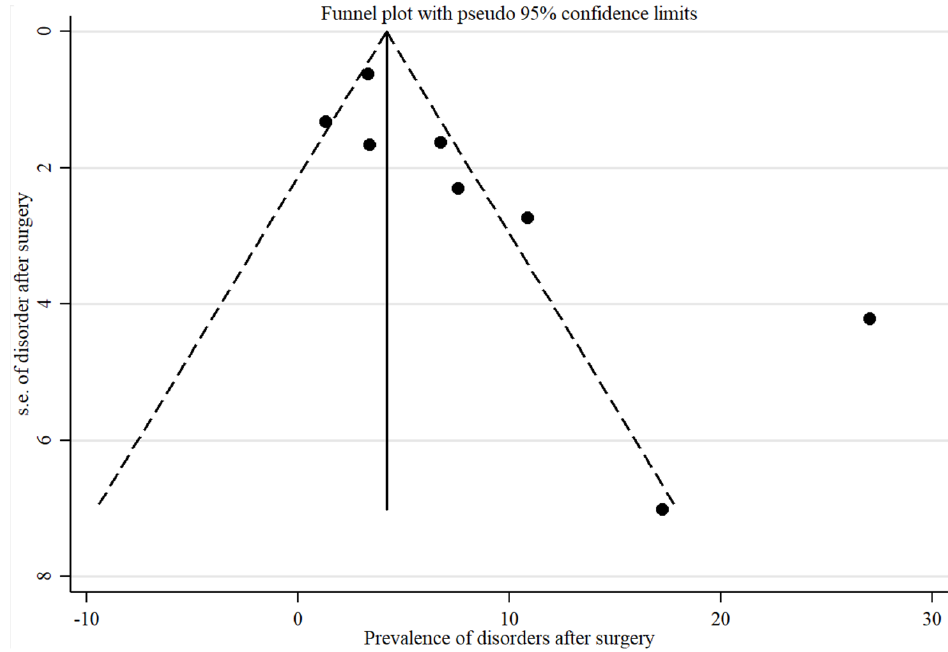
Figure 7. Analysis of publication bias.